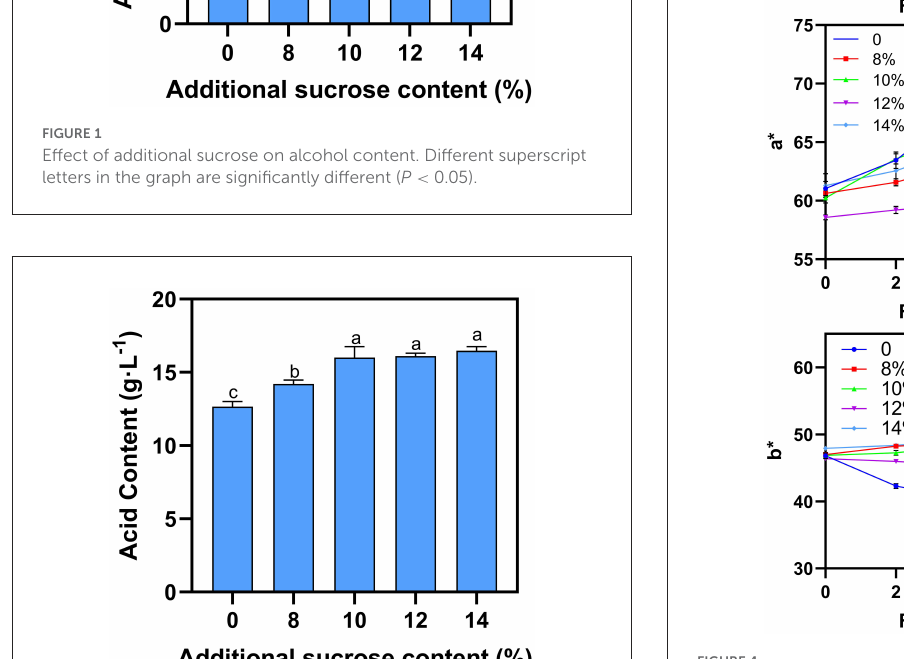
FIGURE4 Effect of additional sucrose on L*, a*, and b* during main fermentation.